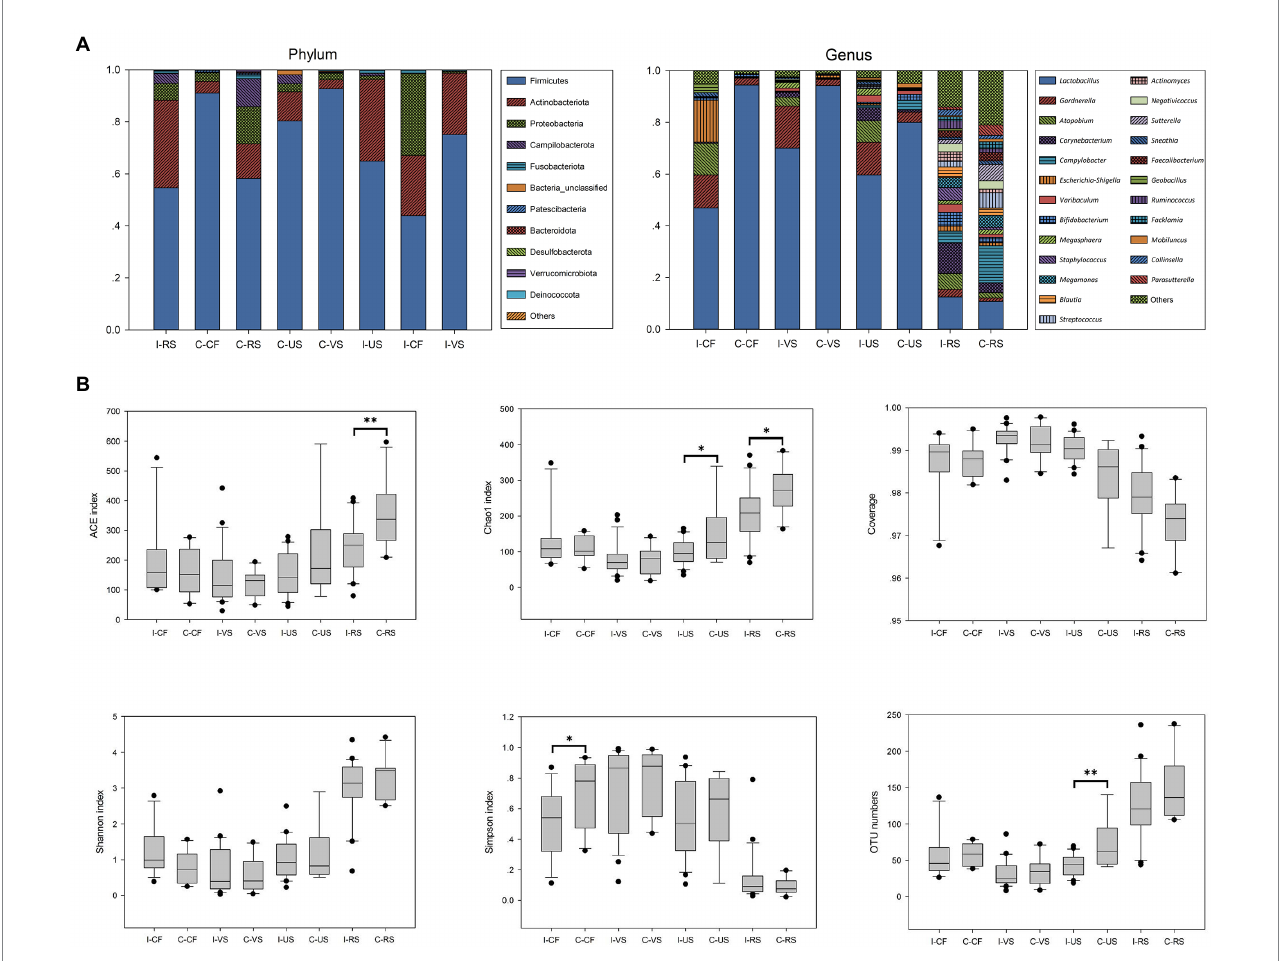
FIGURE 1 Microbial composition and diversity analysis of urogenital tract and rectal. (A) The composition ratio of each microorganism at phylum and genus level, (B) Alpha diversity between different sampling sites based on the OTU numbers, Shannon, Simpson, Chao1, ACE indices and Coverage. t -test, p values represented as * p < 0.05, ** p < 0.01, *** p < 0.001. I- CF , Infertile patients – Cervical fluid; C- CF , Controls – Cervical fluid; I- VS , Infertile patients – Vaginal swabs; C- VS , Controls – Vaginal swabs; I-US, Infertile patients – Urethra swabs; C-US, Controls – Urethra swabs; I-RS, Infertile patients – Rectal swabs; C-RS, Controls – Rectal